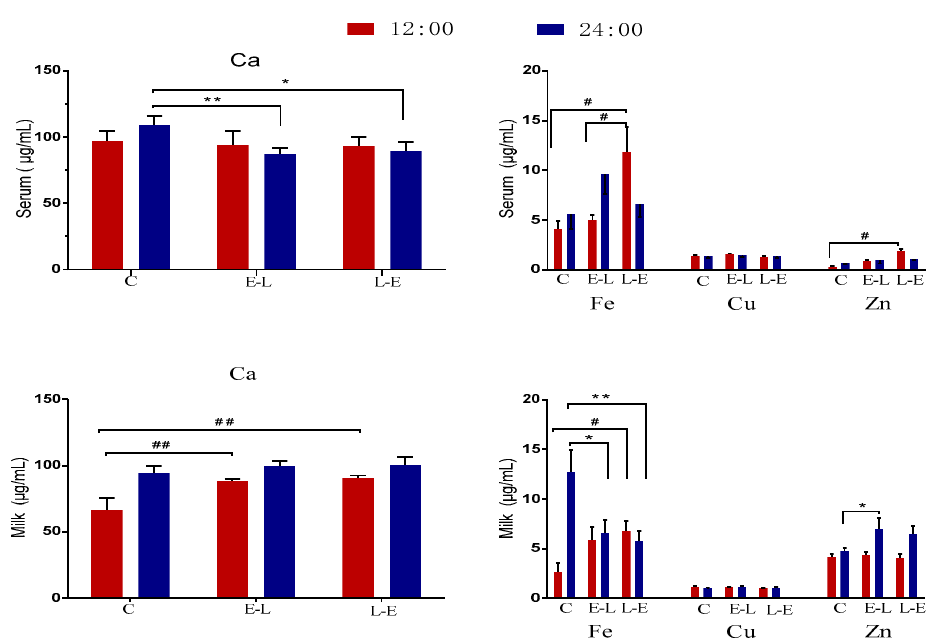
Figure 3. The concentration of Ca, Zn, Cu, and Fe in the serum and milk of sows on day 7 of lactation. Data are presented as mean ± SEM, n = 9. Statistical significances were set at # p < 0.05 and ## p < 0.01 at 12:00 and at * p < 0.05 and ** p < 0.01 at 24:00.